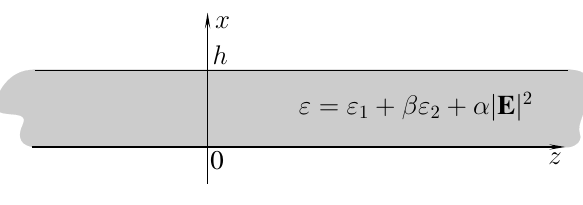
Figure 1. Geometry of the